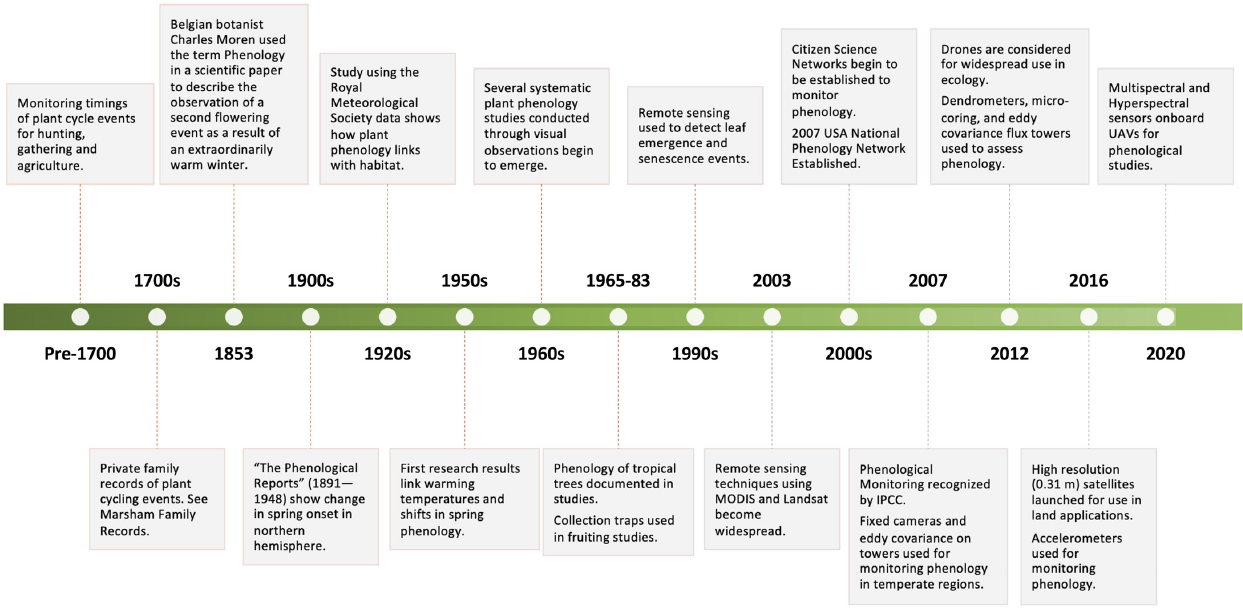
Figure 1. Timeline history of monitoring phenology. References for the specific time periods are: pre-1700 [4], 1700s [8],